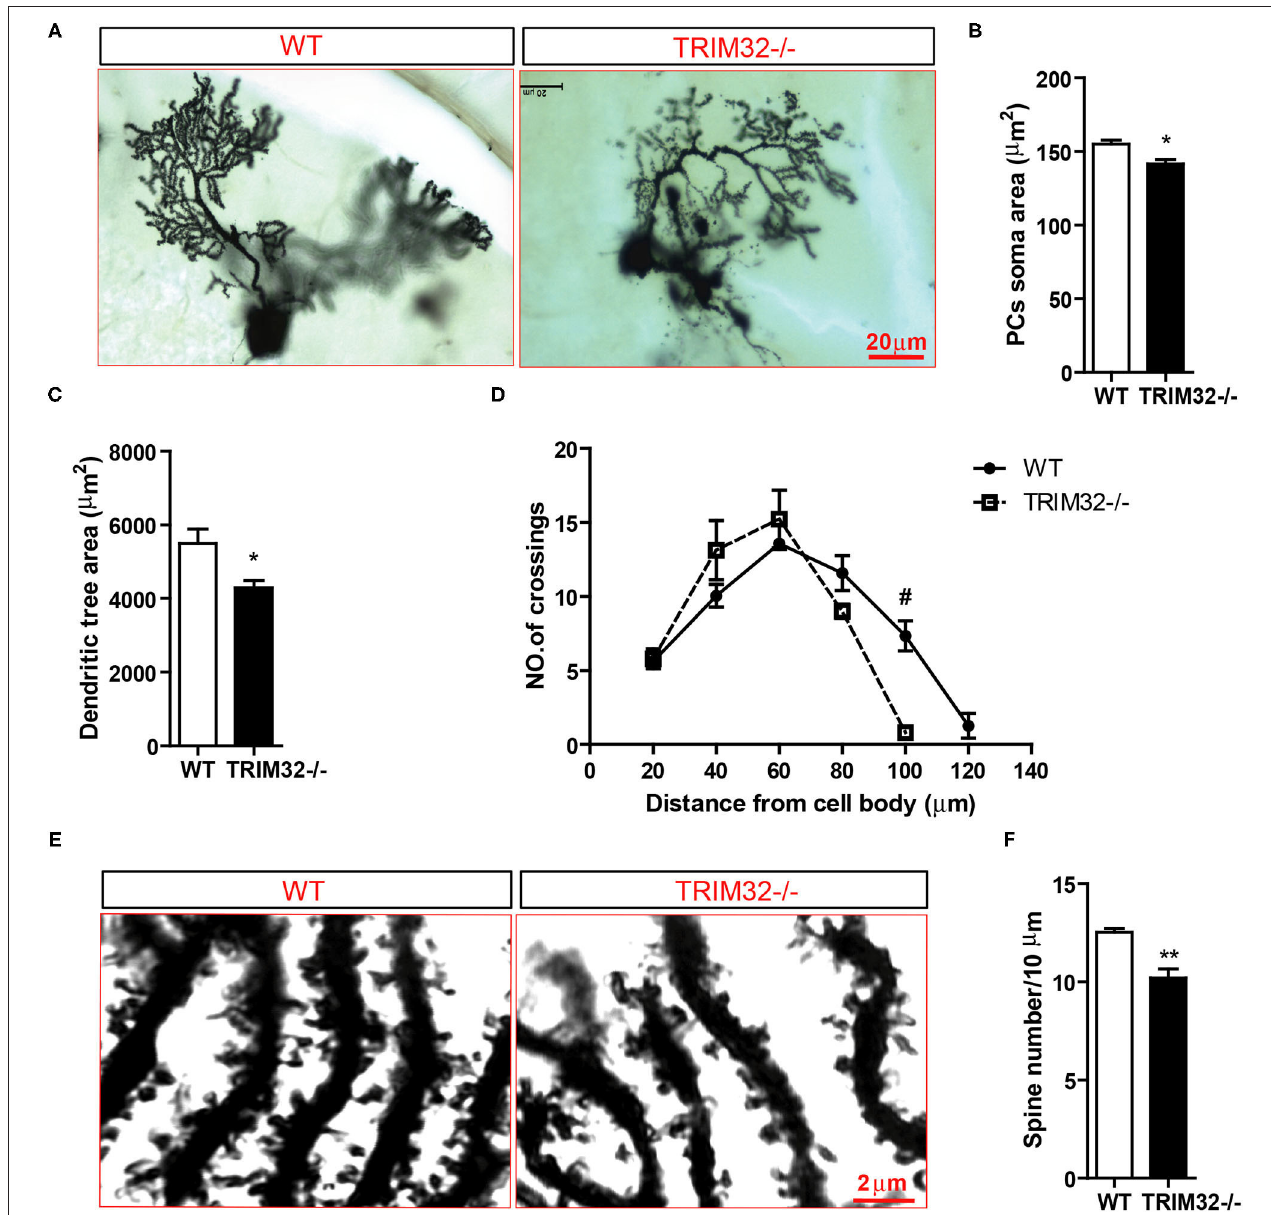
FIGURE 5 | Deficiency of TRIM32 decreases dendritic arborization and spine density of PCs. (A) Representative micrographs of stained Golgi of single PCs from TRIM32 − / – and WT mice. (B,C) Quantitative analysis of the somata area (B) and dendritic tree area (C) of PCs. (D) Sholl analysis of the numbers of the dendrites at different distances from the cell body. (E) High magnified images of distal dendritic branching of PCs. (F) Quantitative analysis of the distal dendritic spine density. Scale bar = 20 µ m (A) , 2 µ m (E) . Data are presented as mean ± SEM. n = 5 mice/genotype. * p < 0.05; ** p < 0.01; # p < 0.008. For the statistical analysis in D, t -test with Bonferroni correction was performed, p < 0.05/6 was considered statistically significant.